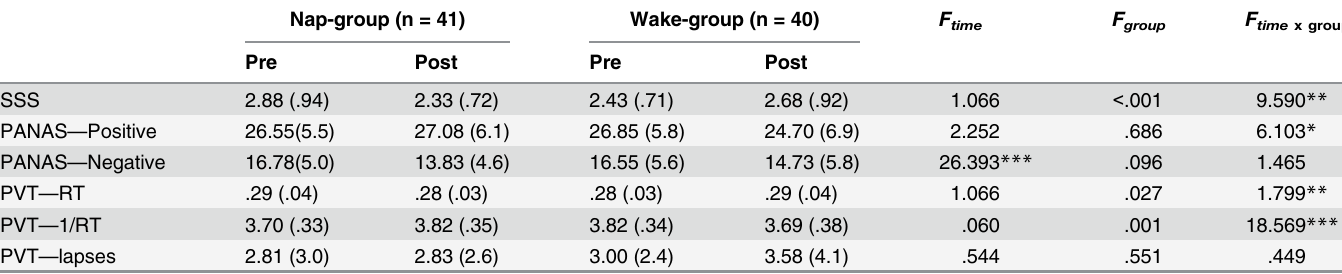
Table 3. Between-group comparisons on